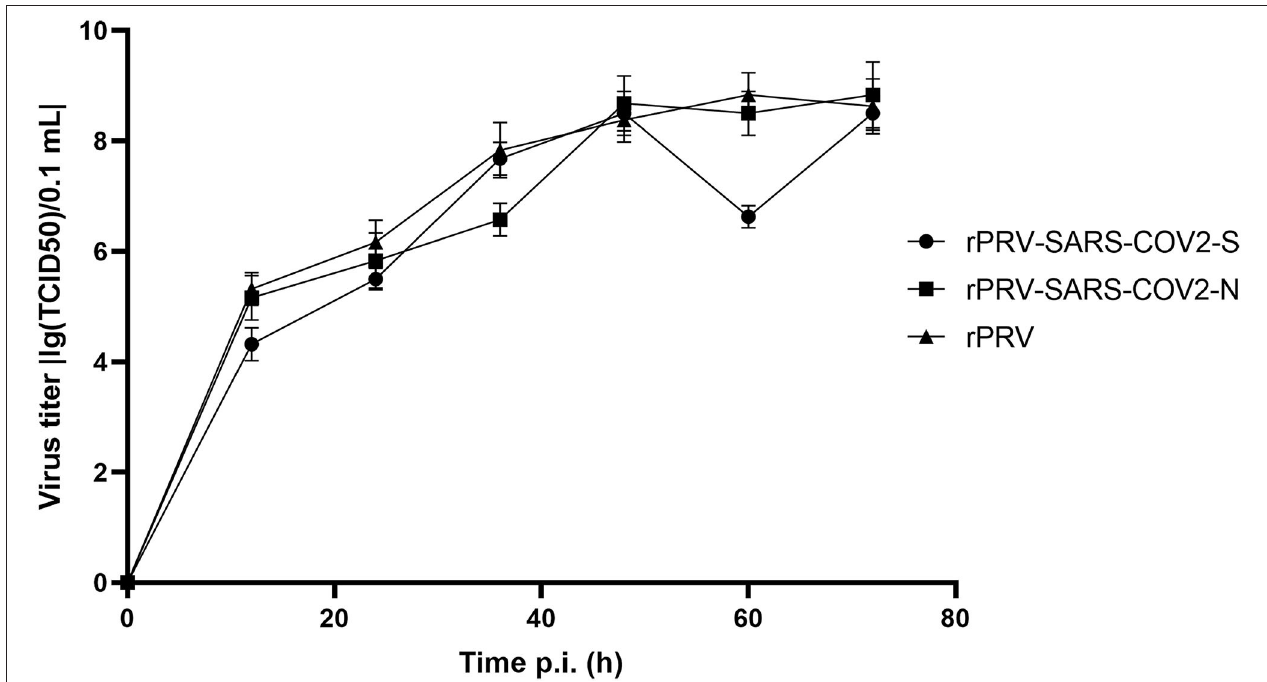
FIGURE 6 | Growth kinetics of the recombinant virus and rPRV in PK-15 cells. Infected cells and supernatants were collected, and viral titers were determined at the indicated time points post-inoculation.